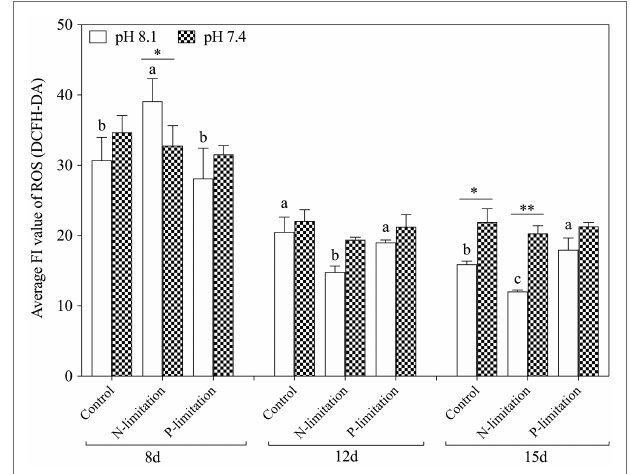
FIGURE 6 | Changes in ROS levels in K. mikimotoi under seawater acidification conditions when exposed to different nutrient levels. Data are presented as means ± SD. Different lowercase letters indicate significant differences among three nutrient levels within each pH treatment at each time point ( p < 0.05). Asterisks indicate significant differences between two pH levels within each nutrient treatment ( p < 0.05).